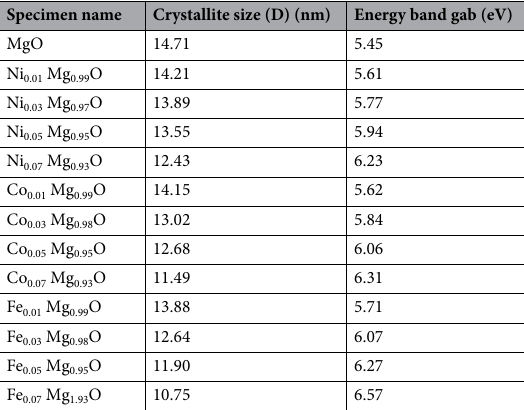
Table 1. Specimen name, the average crystallite size (D) of the specimens, and energy band gab.